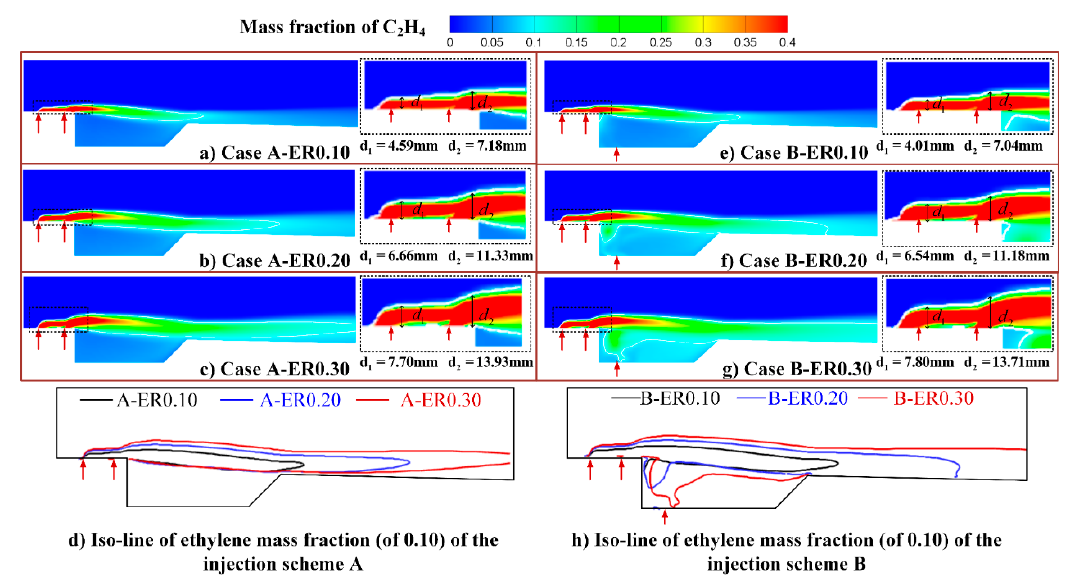
Figure 12. Ethylene mass fraction distributions in the planes of the upstream jet orifice of the injection Schemes A and B cases (the fuel jet penetration depths of the upstream injection ( d 1 and d 2 ) increase as the ER increases; the iso-lines of ethylene mass fraction (of 0.10) are compared to investigate the effect of the ER on the transport of ethylene into the cavity).